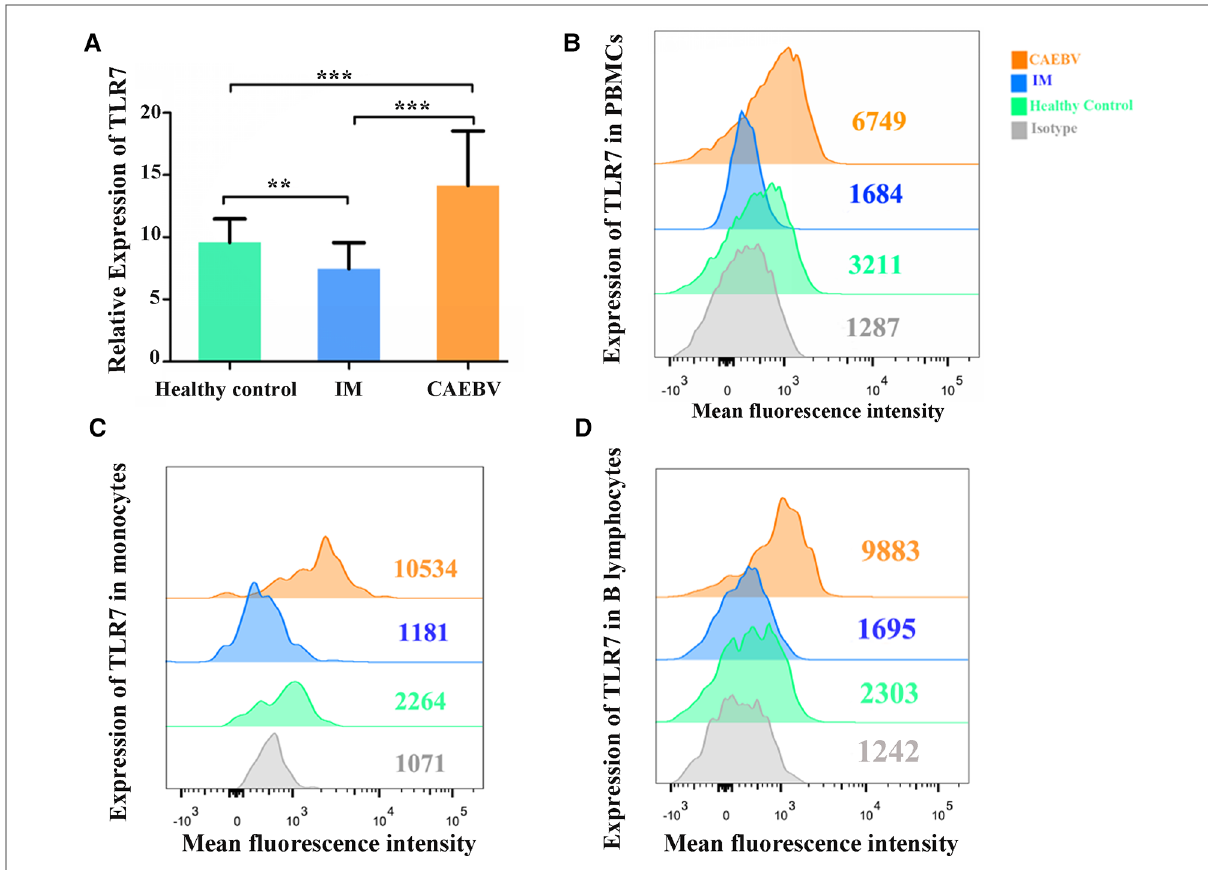
FIGURE 1 TLR7 expression is associated with EBV infection. ( A ) MRNA accumulation of TLR7 was measured in PBMCs from healthy controls (age matched, n =20), IM patients ( n =20) and CAEBV patients ( n =10). ( B ) Flow cytometry analysis showed the levels of TLR7 protein. ( C ) The expression of TLR7 in CD19+ B lymphocytes by fl ow cytometry analysis. ( D ) The expression of TLR7 in CD14+ monocytes by fl ow cytometry analysis. (** p < 0.01 and *** p <0.001 by Duncan ’ s